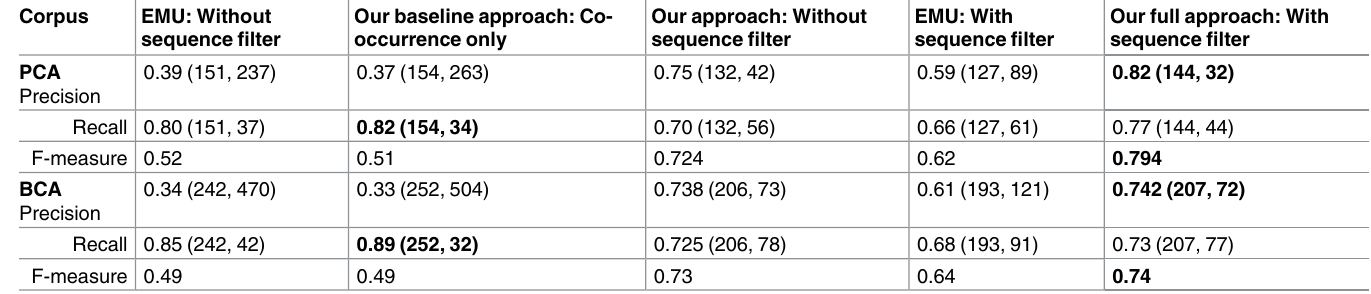
Table 1. Comparison of proposed approach with EMU approach on benchmark datasets. The paranthesesvalues correspondto (true positives, false positives)for precisionand (true positive, false negatives)for recall. Corpus EMU: Without sequence filter